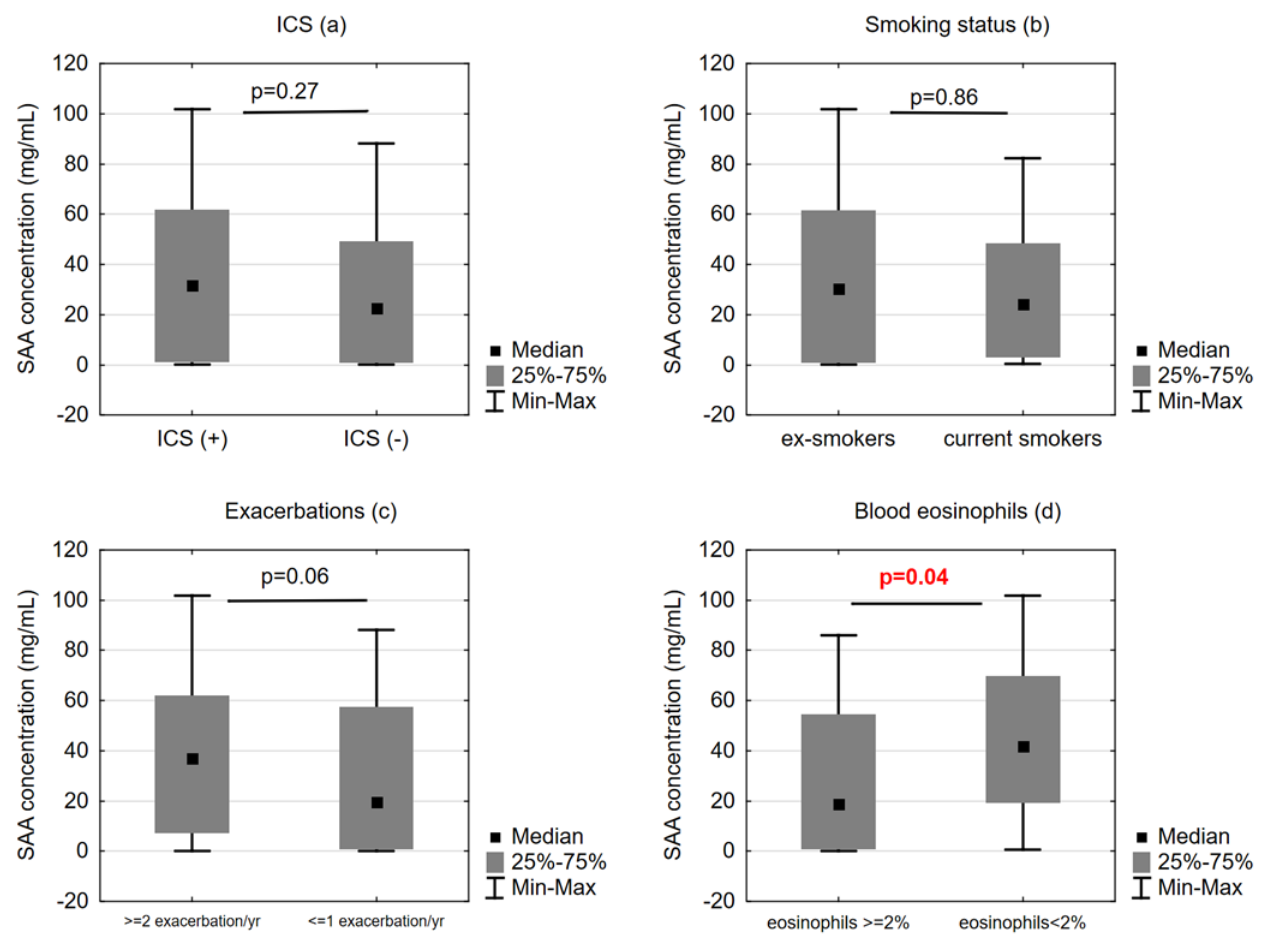
Figure 2. Comparison of serum amyloid A (SAA) concentration between ( a ) patients treated and not treated with inhaled corticosteroids (ICS/+/and ICS/-/, respectively), ( b ) ex-smokers and current smokers, ( c ) patients with ≤ 1 exacerbation and ≥ 2 exacerbations in the last year, ( d ) patients with and without blood eosinophilia.